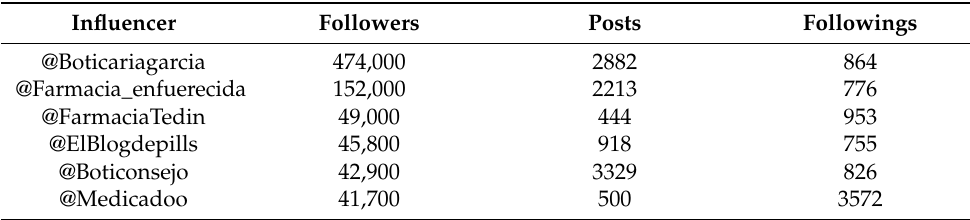
Table 1. Instagram user interaction metrics from October 2021–March 2022.